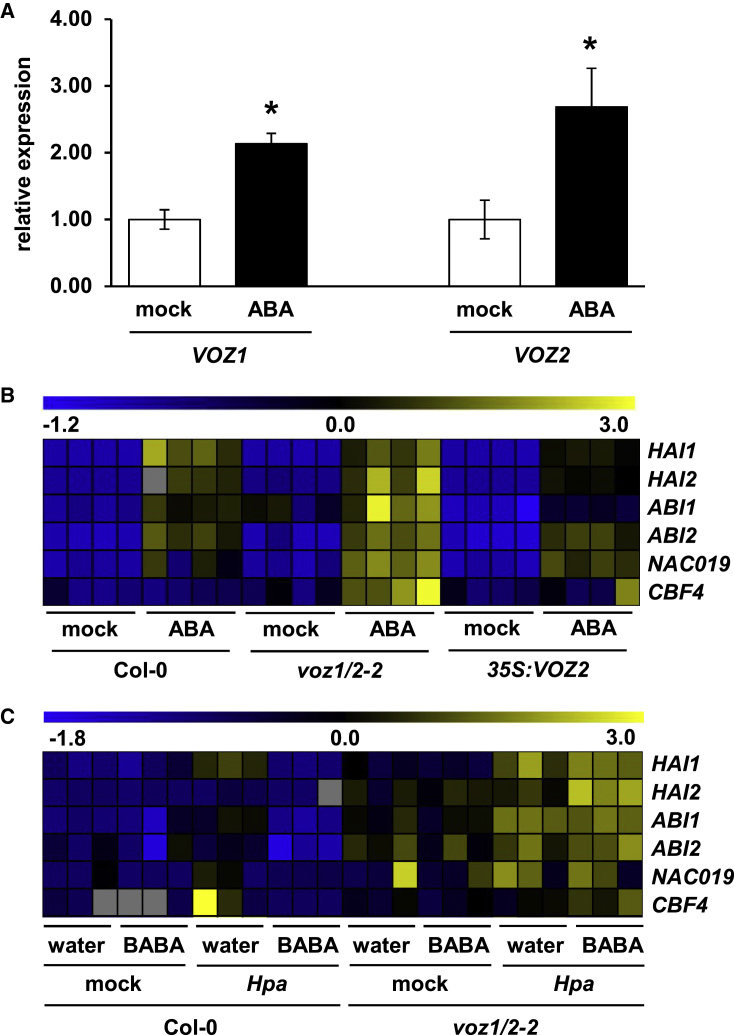
VOZ1 and VOZ2 Are Transcriptionally Inducible by ABA but Repress Hpa-Induced ABA Signaling during BABA-IR.(A) The VOZ1 and VOZ2 genes are transcriptionally induced by shoot application of abscisic acid (ABA). Two-week-old plants were sprayed with a 0.01% Silwet +0.5% EtOH solution (mock) or 0.01% Silwet +100 μM ABA. Shoot tissues were collected for qRT–PCR analysis at 8 h after treatment. Data represent mean expression values (±SEM) relative to mock-treated Col-0 plants. Asterisks indicate statistically significant differences between control and ABA treatments (Student's t-test; p < 0.05; n = 4).(B) VOZ1/2 repress ABA-inducible genes marking the abiotic stress response. Two-week-old Col-0, voz1/2-2,and 35S:GFP-VOZ2 plants were sprayed with 0.01% Silwet + 0.5% EtOH (mock) or 0.01% Silwet + 100 μM ABA. Replicate shoot samples for qRT–PCR analysis were collected 1 day after ABA treatment (n = 4). Heatmap projections show expression values of six ABA-inducible marker genes, row-normalized to the average expression value of mock-treated Col-0 samples. Gray cells indicate missing values.(C) VOZ1/2 repress the ABA-dependent abiotic stress response during BABA-IR against Hpa. Two-week-old Col-0 and voz1/2-2 plants were soil-drenched with water or BABA (5 mg/l) and challenge-inoculated with mock or Hpa 2 days later. Replicate shoot samples for qRT–PCR analysis (n = 3) were collected at 4 dpi. See legend of (B) for details.